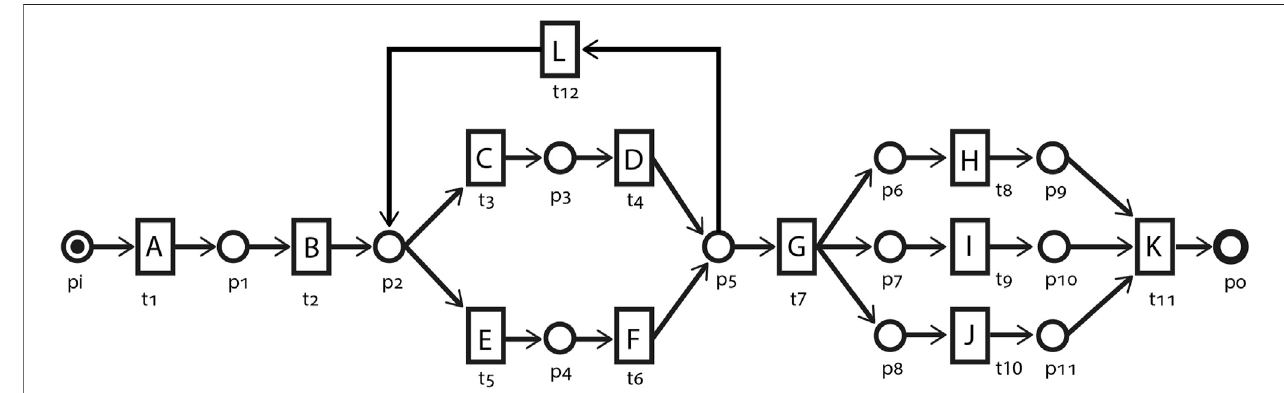
FIGURE 2 | An example of a process model represented as a Petri net N , consisting of places { p 1 , p 2 , ... } and transitions { t 1 , t 2 , ... } labeled with activity names { A , B , ... } and inter-connected through directed arcs F .